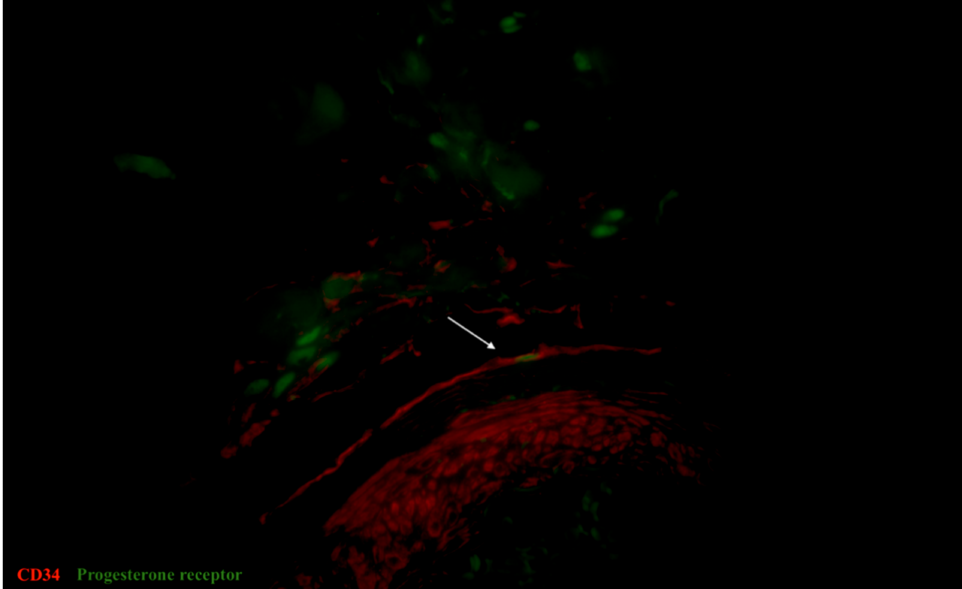
Figure 9. Sample of human oviduct stained for CD34 (red, Alexa Fluor 594) and progesterone receptor (green, Alexa Fluor 488). The cell with immunopositive for CD34 cellular body and two long cellular prolongations, which has an immunopositive nucelus for progesterone, was identified as tubal telocyte (shown by arrow). This double immunopositive cell was revealed in the muscular layer. Total magnification: ×